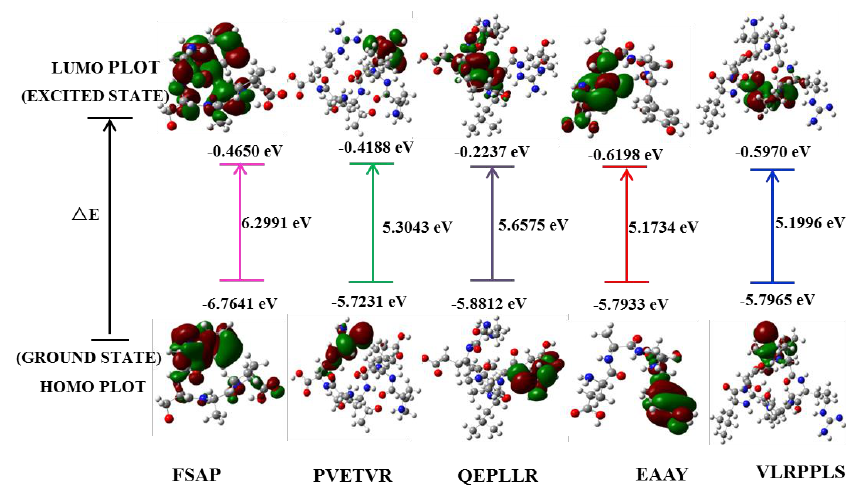
Figure 4. The frontier molecular orbital of five novel peptide molecules: the data on the line and below the line represent the lowest unoccupied molecular orbital (LUMO) and the highest occupied molecular orbital (HOMO) value, respectively. The data between the lines represents the LUMO and HOMO energy gap values expressed as ∆ E, and the unit is expressed by eV.